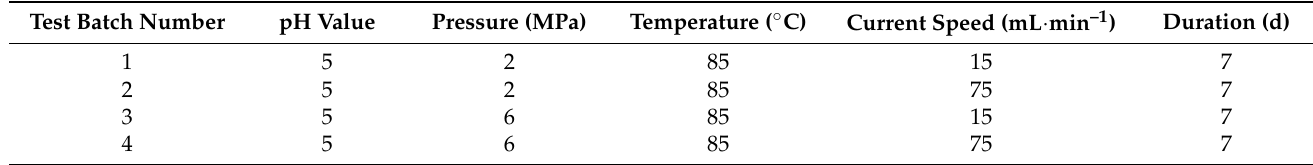
Table 3. Dissolution conditions under Four groups of